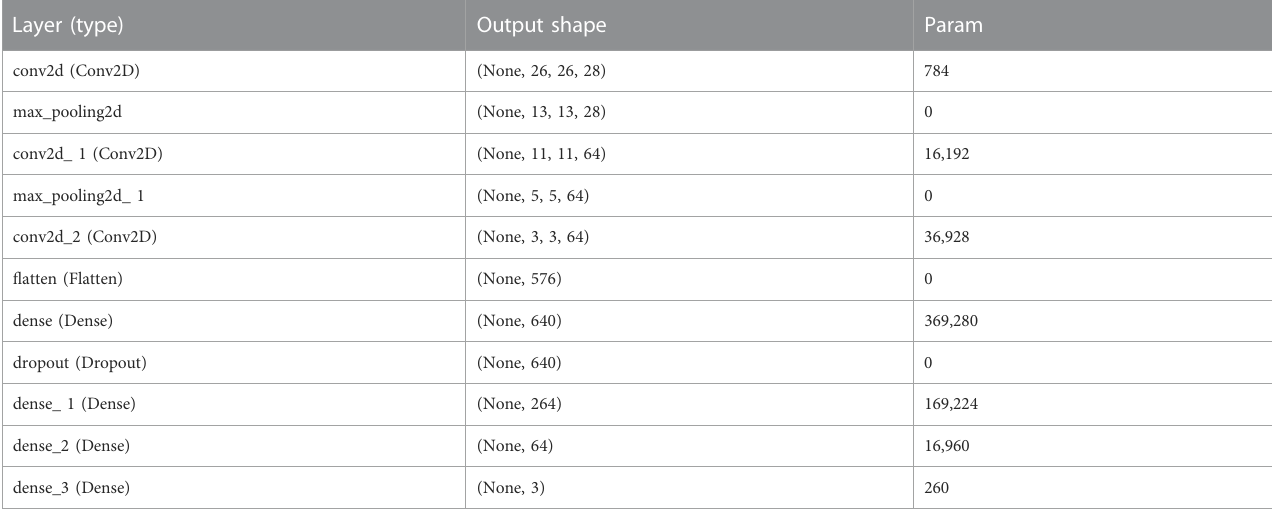
TABLE 3 Hyper Parameters details used in ResNet-50 model according to our